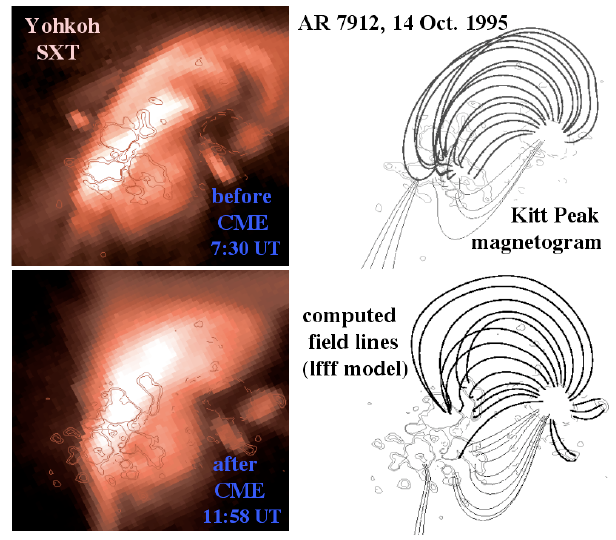
Fig. 17. Evolution of the X-ray emission and of the coronal magnetic field before and after the ejection accompanying a long duration event which is the signature of a CME. Left panels: co-aligned soft X-ray images overlaid with longitudinal magne- tograms. Right panels: coronal linear force-free field models. Iso- contours ( ± 70, ± 140G) are drawn with continuous/dashed lines for positive/negative magnetic field values. The deduced loss of coronal magnetic helicity is comparable to the helicity found in the associ- ated MC observed at 1AU (Luoni et al.,